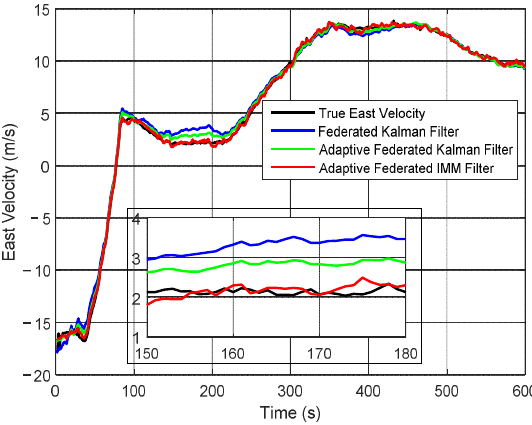
Sensors 2020 , 20 , x FOR PEER REVIEW Figure 13. The estimation curves of east velocity. Figure 13. The estimation curves of east velocity.